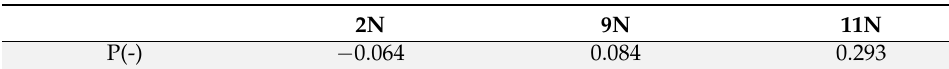
Figure 12 . NCI isosurface ( left ), contour maps of electron density ( right ) of SiN-Imd-Py . Table 8 . (p-) of significant atoms in a.u.